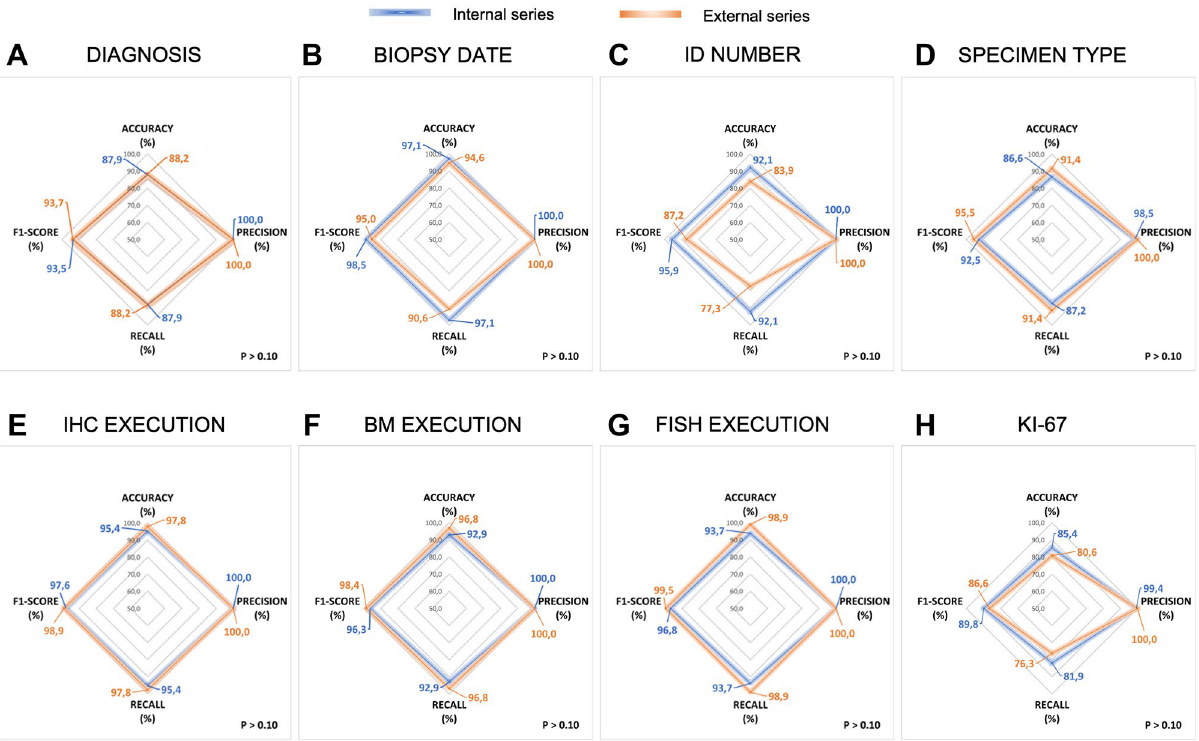
Figure 3. ARGO performance. Radar graphs indicate the performance metrics as percentage of accuracy, precision, recall and F1-score in different data fields for both internal and external series of pathology reports.